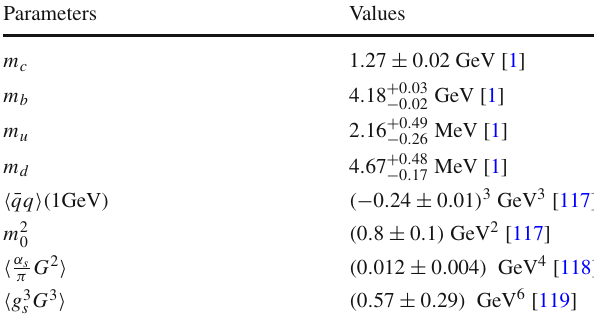
Table 1 The parameters used as input in the analyses Parameters